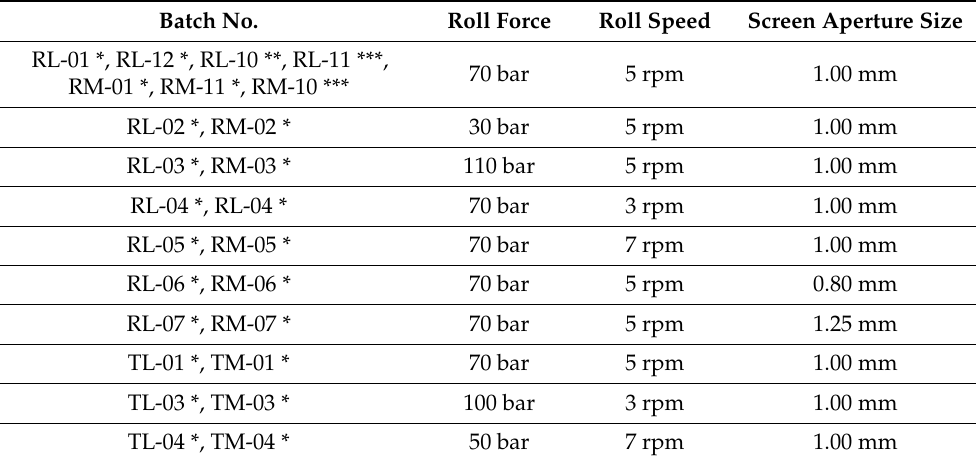
Table 1. Process parameters of batches utilized in the study. Batch